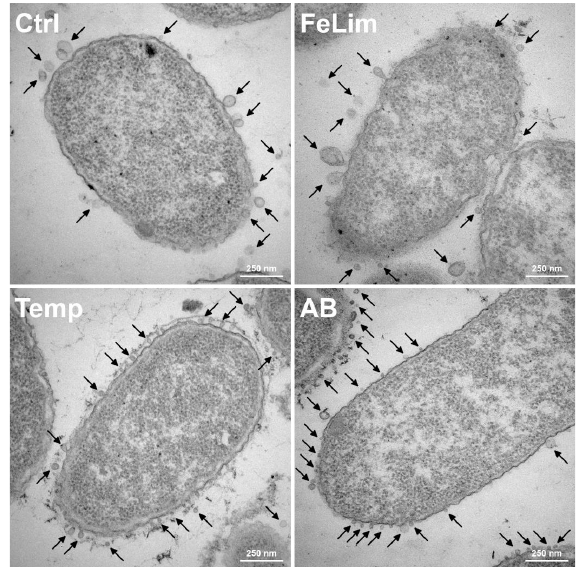
Figure 6. Transmission electron micrographs of Aeromonas salmonicida under control (Ctrl), iron limitation (FeLim), elevated temperature (Temp), and antibiotic stress (AB) conditions. Arrows indicate OMVs. Scale bars = 250 nm.